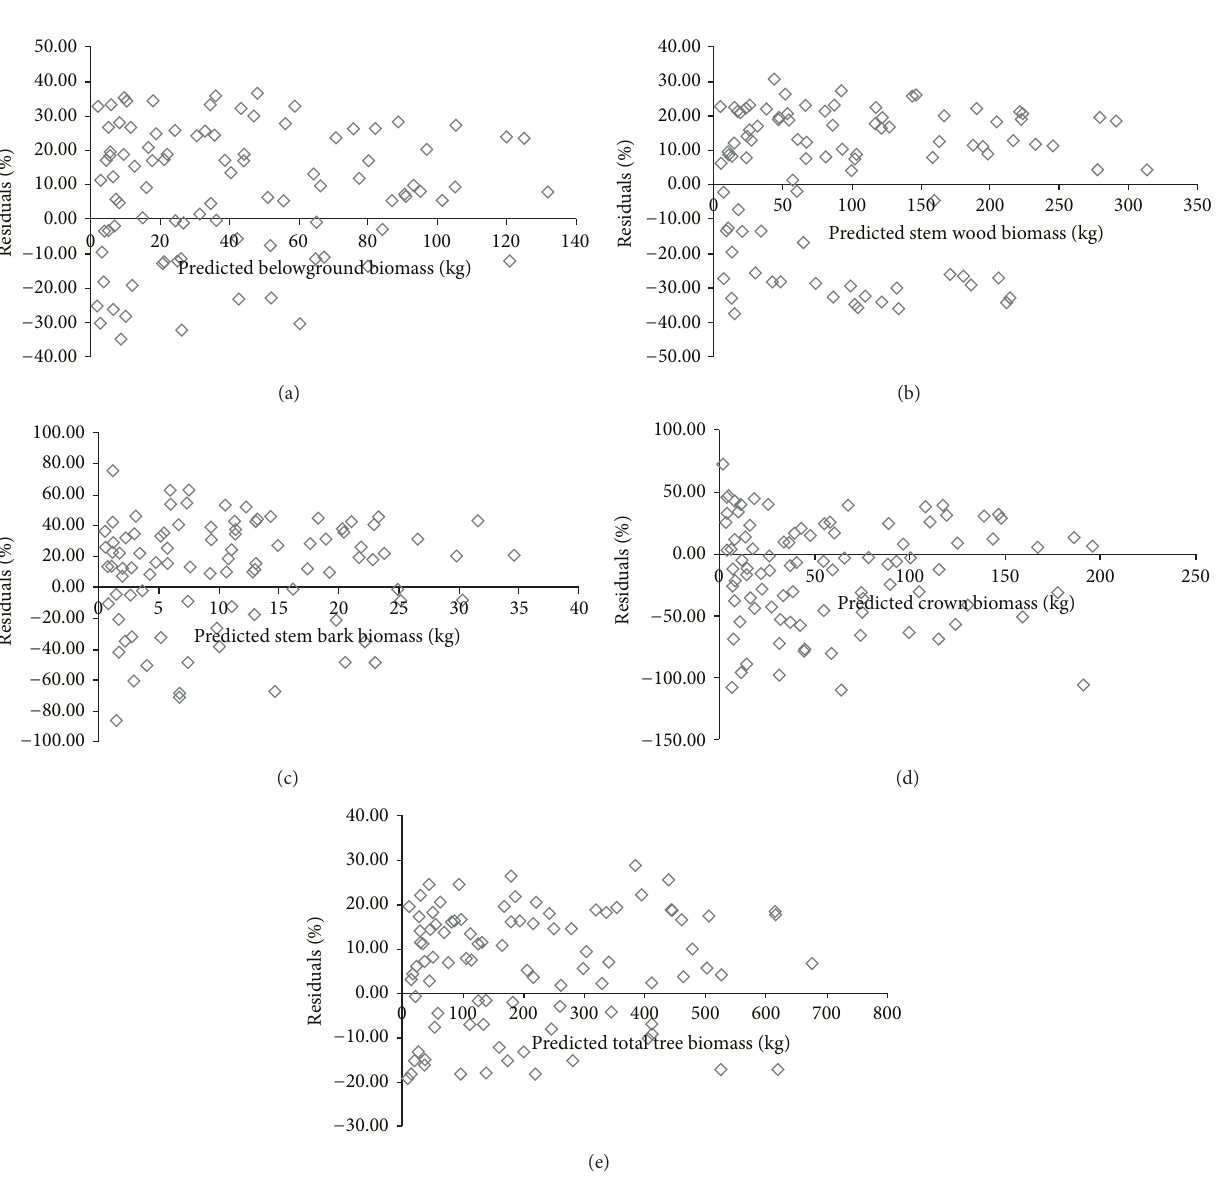
Figure 4: Residuals against predicted biomass for the NSUR method: (a) belowground, (b) stem wood, (c) stem bark, (d) crown, and (e) total tree